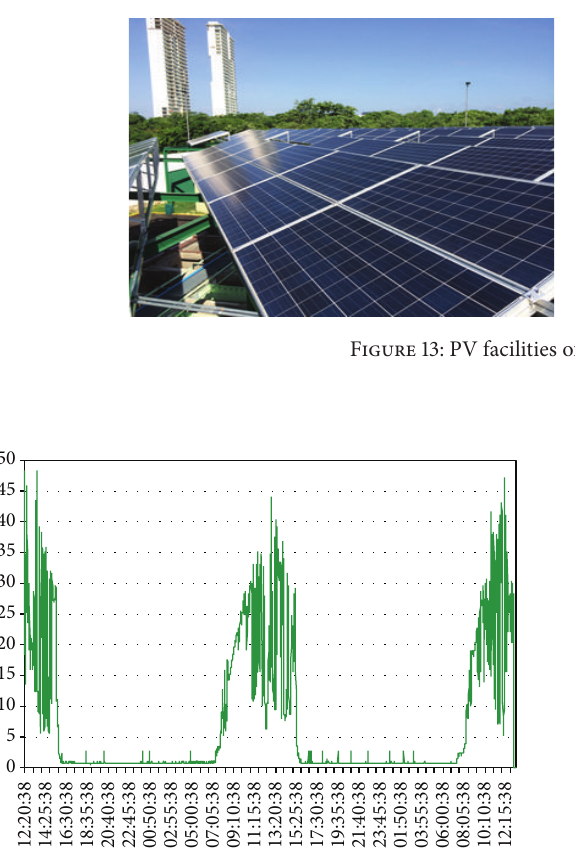
Figure 14: Photovoltaic power generated.